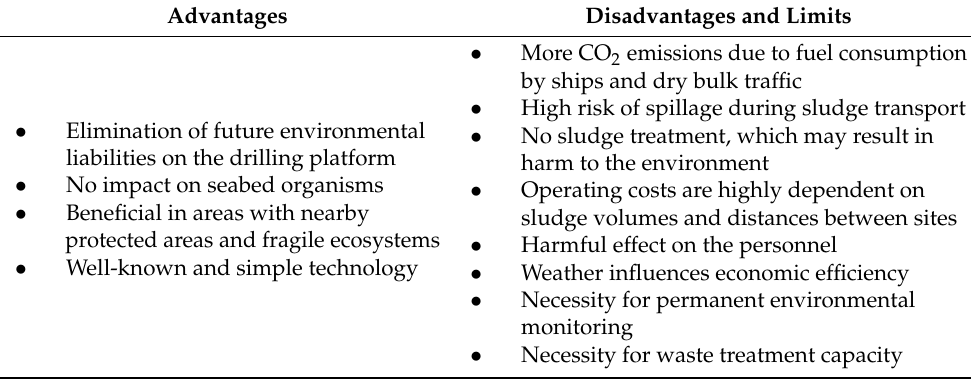
Table 7. Advantages and disadvantages of the Skip and Ship method [61].